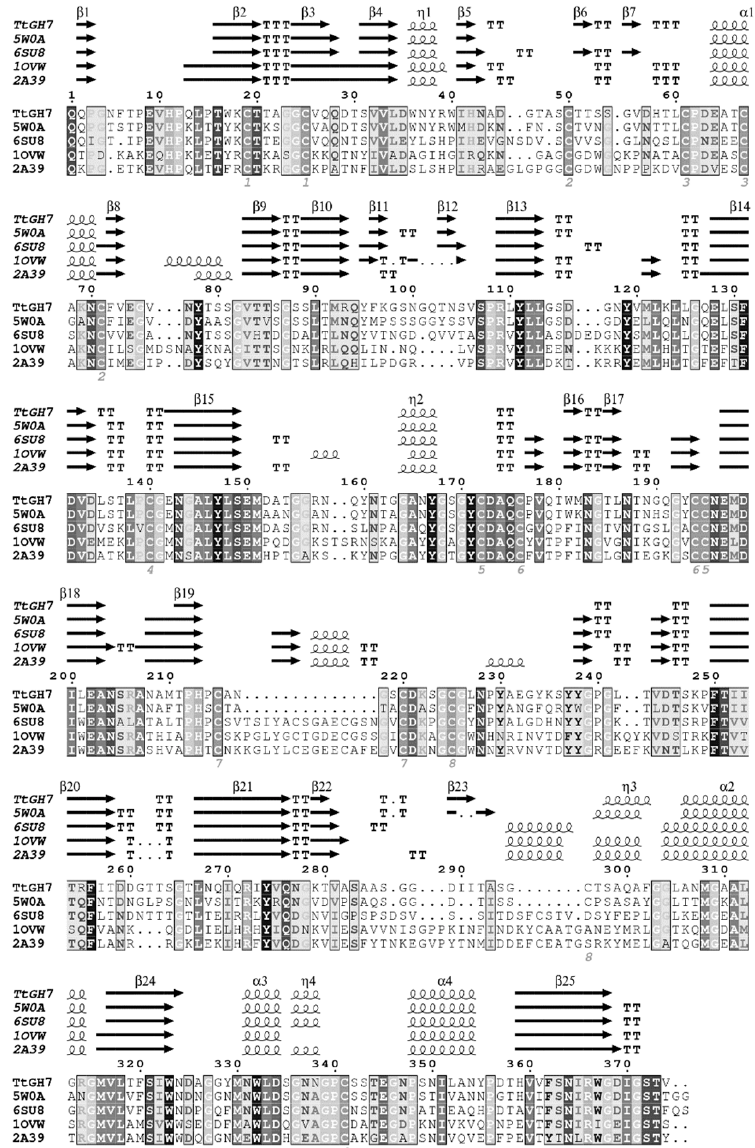
Figure 1. Multiple sequence alignment and secondary structure estimation of the endoglucanase Tt Cel7B (TtGH7) of T. terrestris and PDB models from Trichoderma harzianum Cel7B (PDB id